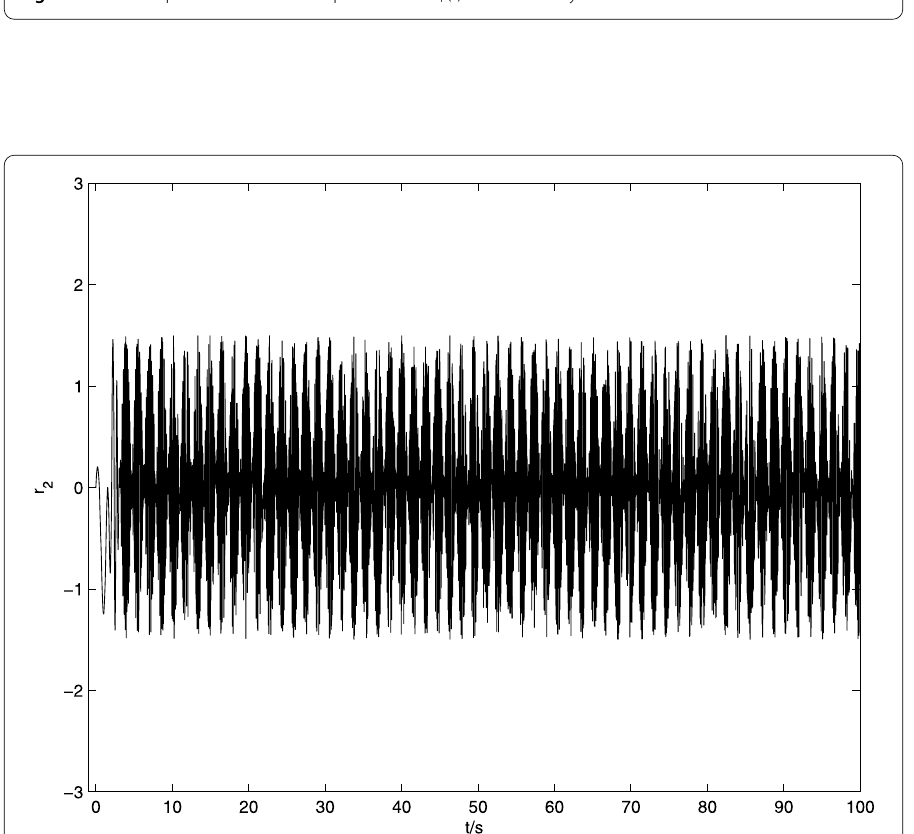
Figure 2 Time response of reference input variable r 2 ( t ) of the Lurie